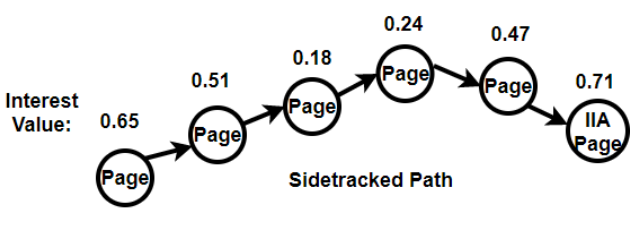
Figure 4. An illustration of post-encountering calculation process with a simple